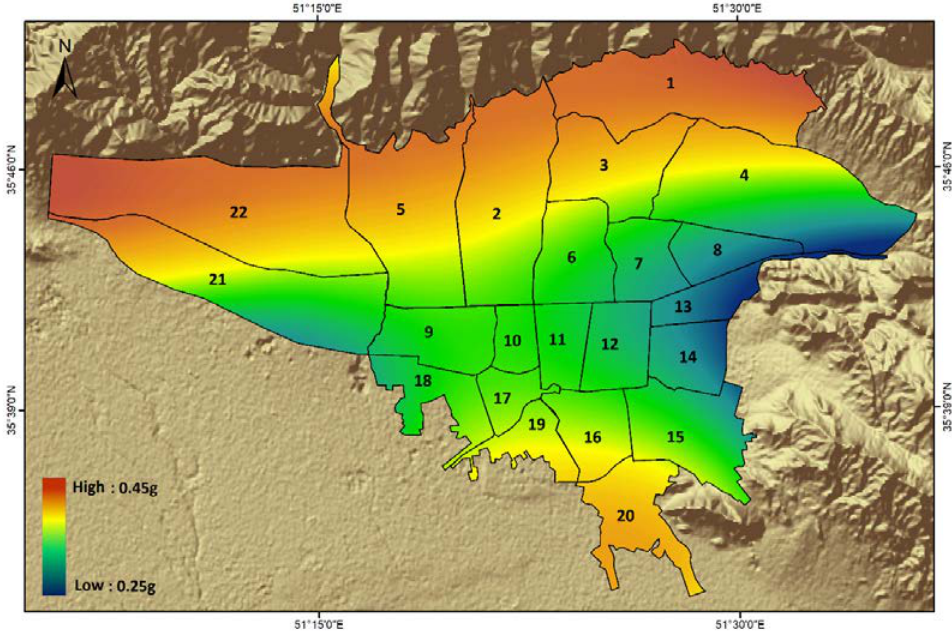
Figure 4. PGA on bedrock for 475-year return period.